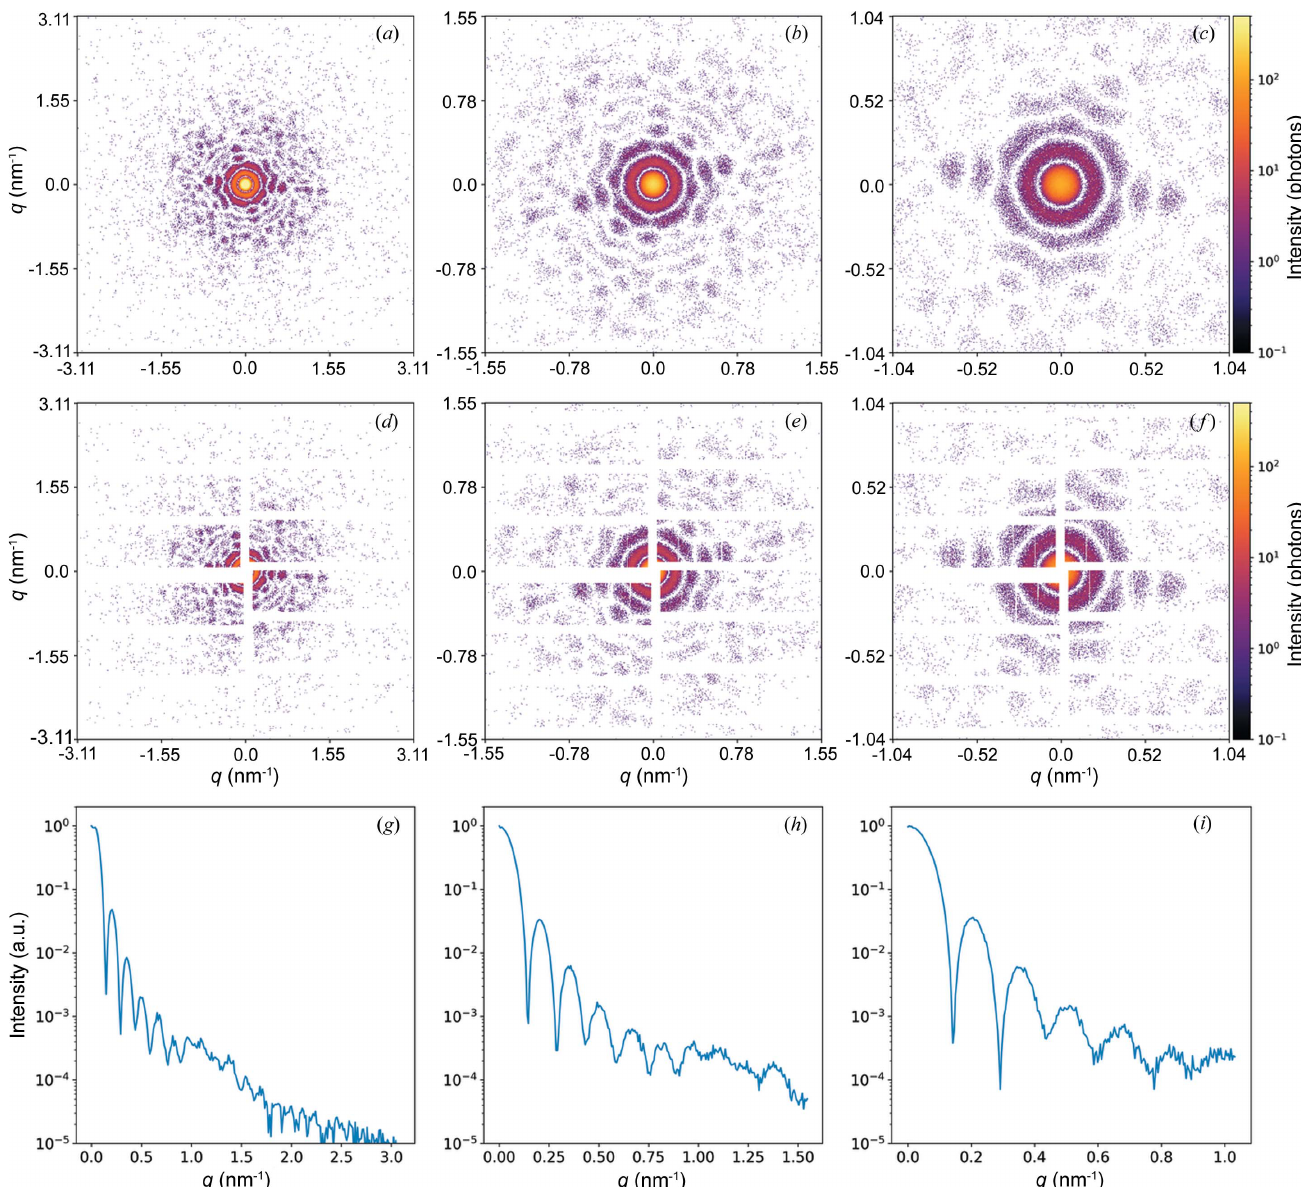
Figure 5 Diffraction patterns from a single TBEV in a random orientation. At sample-to-detector distances of ( a , d , g ) 1 m; ( b , e , h ) 2 m; and ( c , f , i ) 3 m. ( d )–( f ) Examples of diffraction patterns with the detector mask superimposed on them. ( g )–( i ) Angular averaged intensities of the diffraction patterns shown in ( a )–( c ). Detector parameters are the same as in Fig.